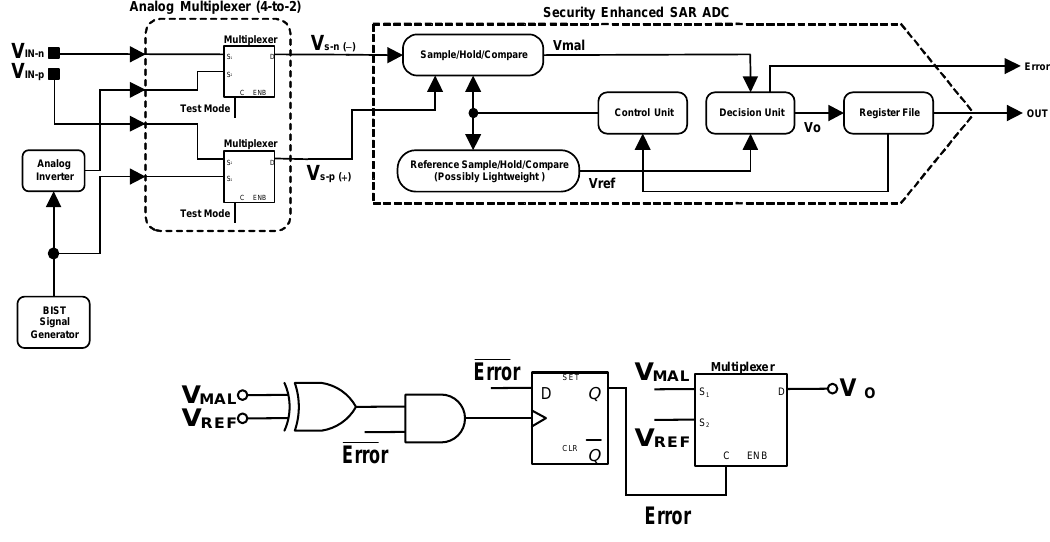
Figure 54. The circuit for the control ‐ path ‐ based countermeasure.